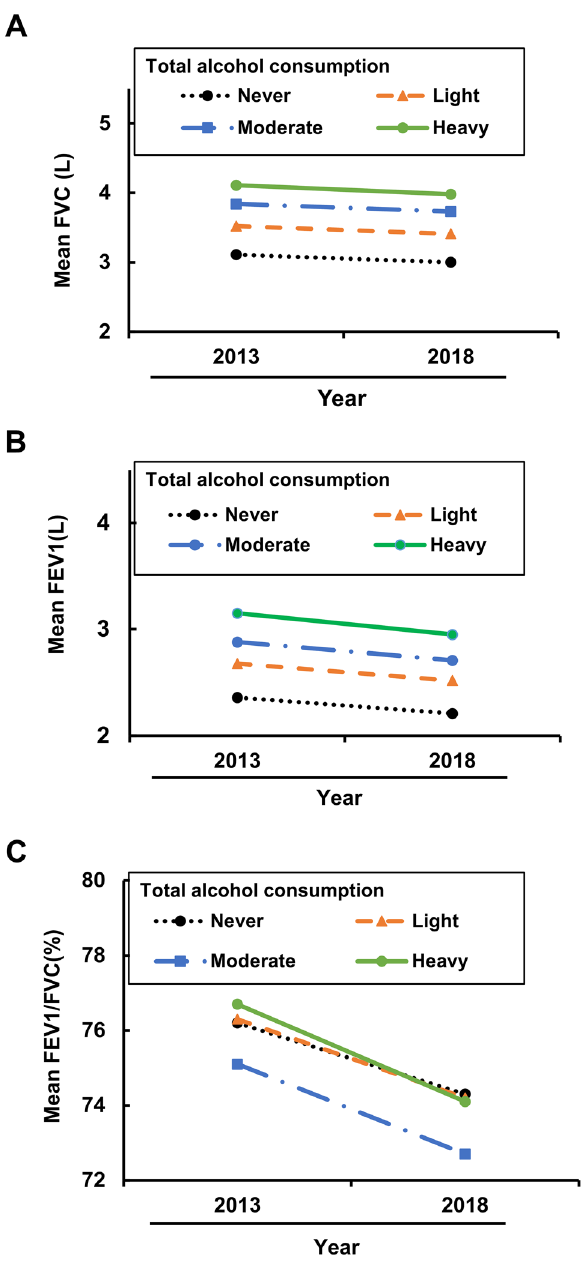
Figure 4. Greater baseline alcohol consumption maintains larger FVC and FEV1 in subjects who did not change their drinking habits during the 5-year study. Subjects were divided into four groups according to their alcohol intake as stated in Supplementary Table S6B, and only those subjects whose category did not change from 2013 to 2018 were analyzed. (A) The mean FVC value in each category of total alcohol intake in 2013 and 2018. Black circles represent never drinkers (n = 411), orange triangles represent light drinkers (n = 327), blue circles represent moderate drinkers (n = 503), green circles represent heavy drinkers (n = 99). These symbols apply to all subplots. 383 subjects were omitted. (B) The mean FEV1 value in each category of alcohol intake in 2013 and 2018. (C) The mean FEV1/FVC ratio value in each category of alcohol intake in 2013 and